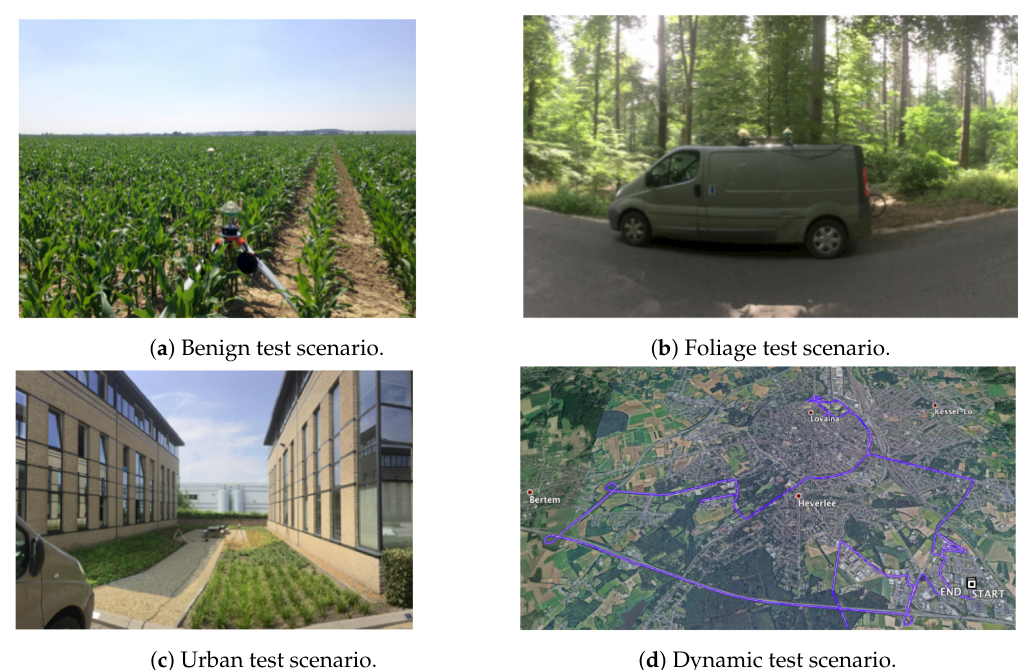
Figure 5. Test scenarios used for the data collection campaign carried out by Septentrio (SSN). ( a ) Static recording attempted to minimize multipath. ( b ) Static recording under trees. ( c ) Static recording between two buildings. ( d ) Truth (pink) and computed (blue)